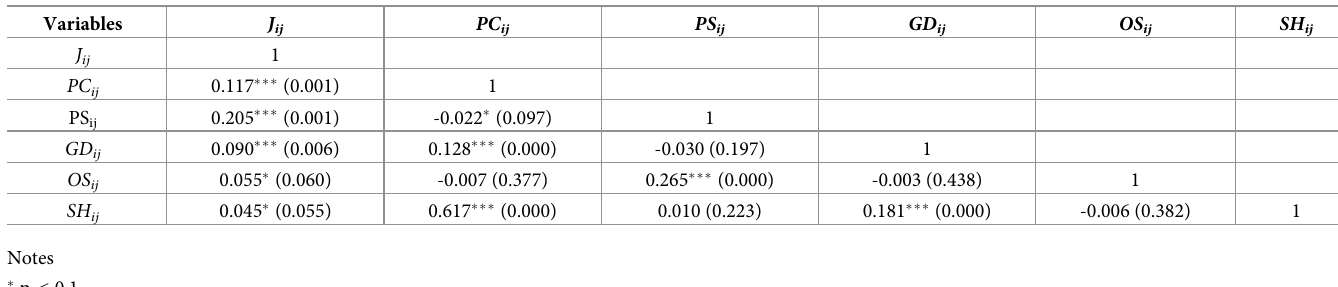
Table 6. Correlation analysis.